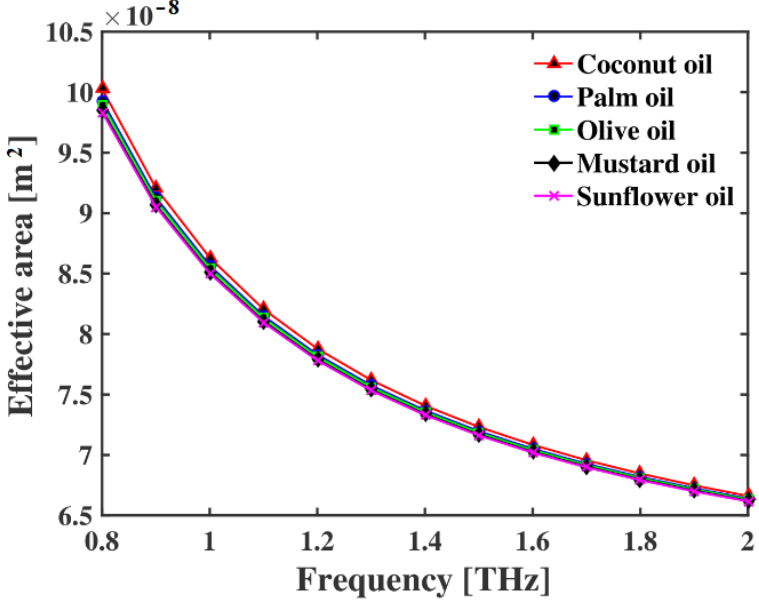
Figure 8. The effective area of the proposed oil detector for different operating frequencies at D = 340 µm.